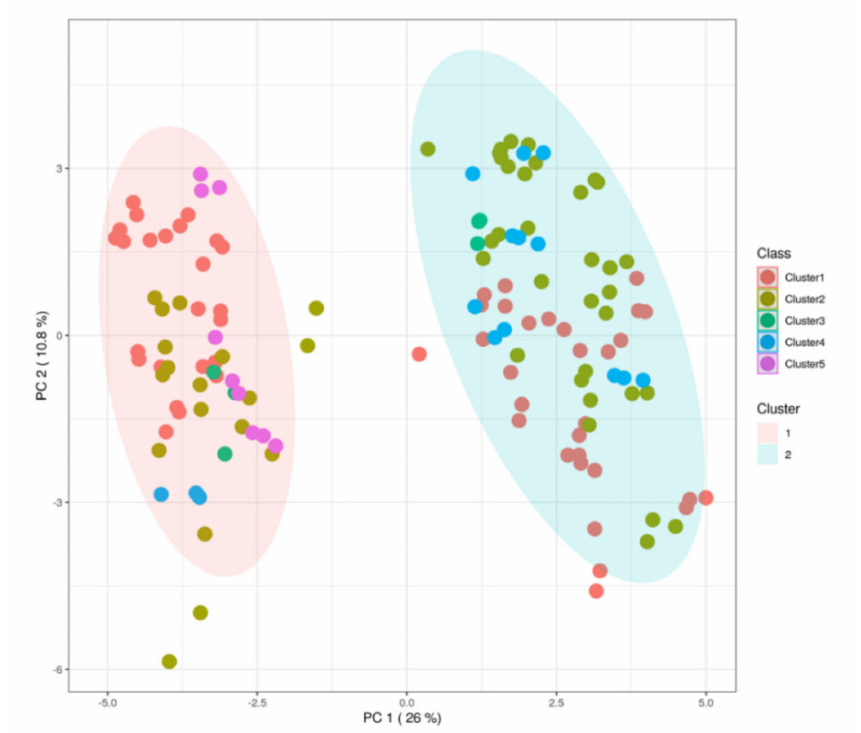
Figure 4. PCA score plot resulting from the unsupervised k-means clustering of the different milk samples under investigation, revealing two major groups according to the mycotoxin contamina- tion profile.